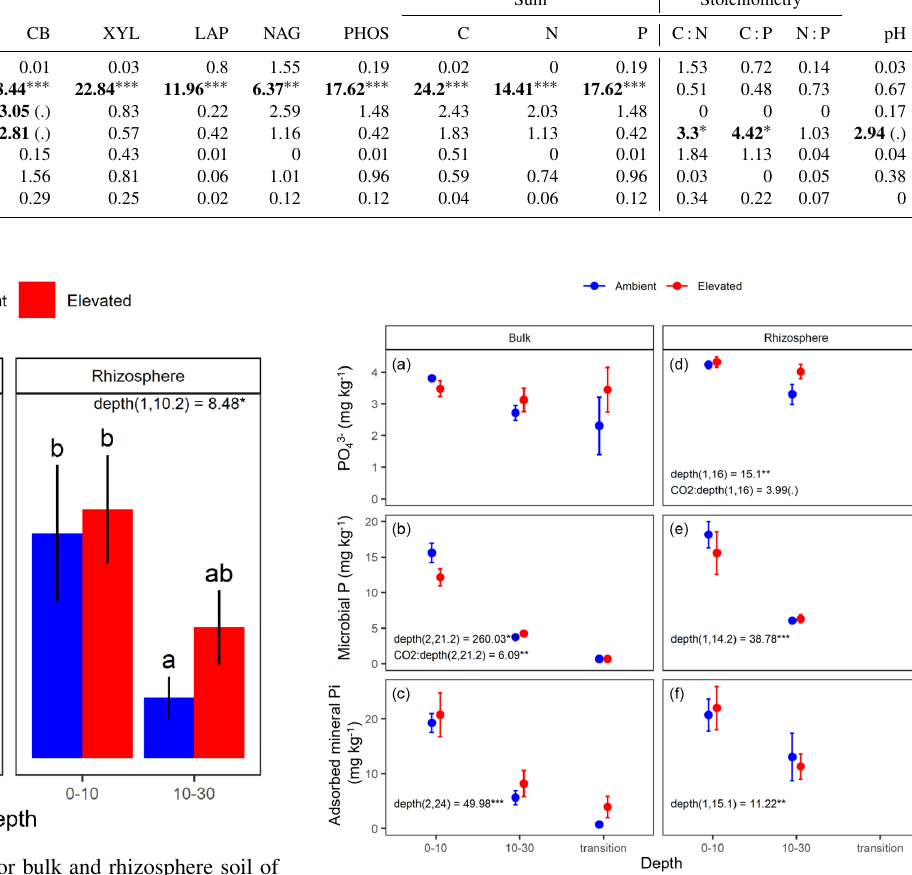
Figure 6. Measured soil P pools in the forms of inorganic P (PO 3 − microbial biomass P, and mineral-associated phosphate through ad- sorption for bulk and rhizosphere soil of the mature Eucalyptus forest soil exposed to ambient (blue) and elevated (red) CO 2 for three depths (0–10 and 10–30cm and transition). Error bars indicate the standard error. Mixed-effects model output is stated (degrees of freedom and Df residuals), and the F statistic is presented. Aster- isks for the P values for significance are as indicated, where ∗∗∗ in- dicate P< 0 . 001, ∗∗ indicate P< 0 . 01, ∗ indicates P< 0 . 05, and (.) indicates a tendency to a significance P< 0 . 1. Results from statisti- cal analysis of comparison of soil types (bulk and rhizosphere) are presented in Table